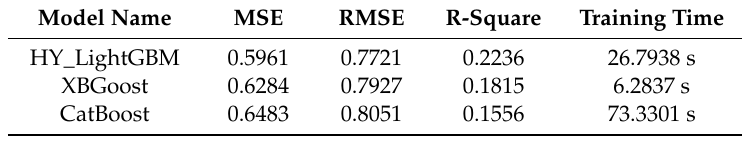
Table 5. Performance comparison of the other models.